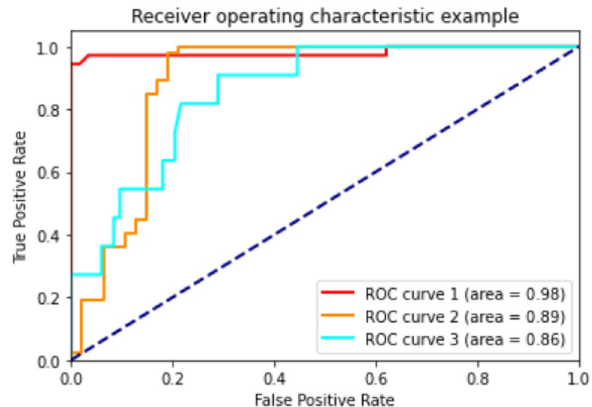
Figure 2. AUROC in RF algorithm for predicting healthy, osteopenia, and osteoporosis in men.